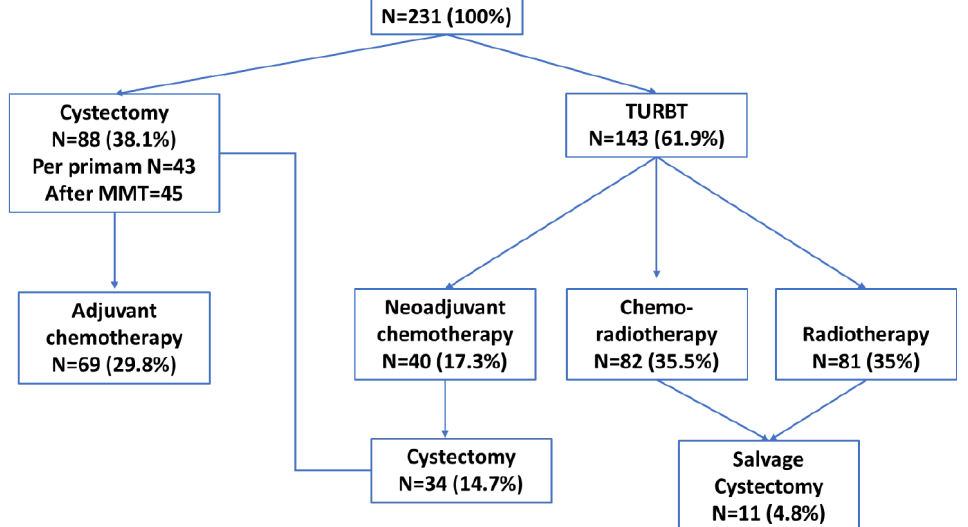
Figure 1. Treatment diagram in the study group. TURBT = trans-urethral resection of bladder tumor, MMT = Multimodality treatment .